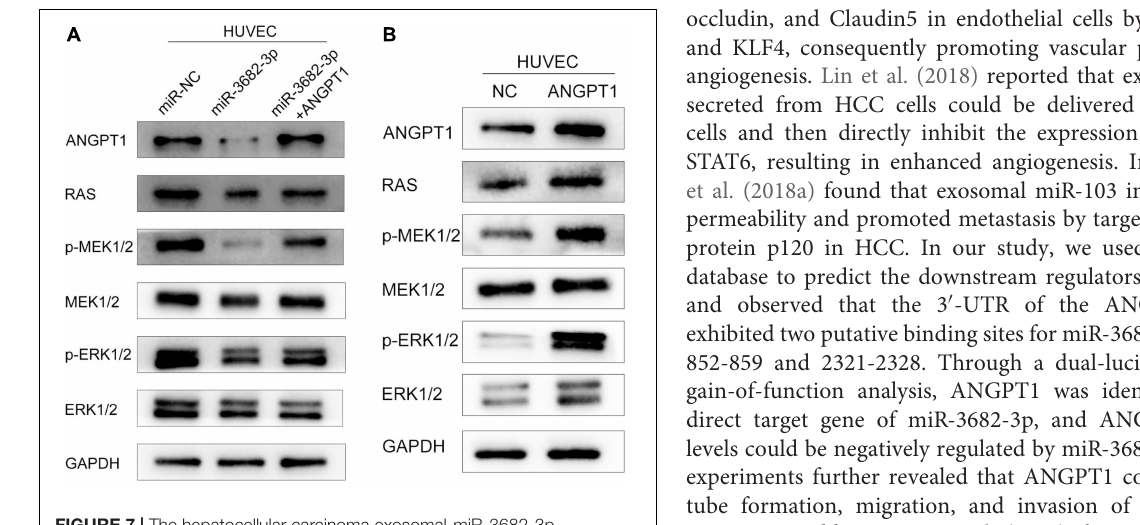
FIGURE 7 | The hepatocellular carcinoma exosomal-miR-3682-3p suppressed HUVECs via ANGPT1-RAS-MEK1/2-ERK1/2 signaling axis. (A) Exosomal-miR-3682-3p suppressd the expression of p-MEK1/2, p-ERK1/2, and ANGPT1 and this effet can be counteract by ANGPT1. (B) Western blot assays showed that overexpression of ANGPT1 also activated the RAS-MEK1/2-ERK1/2 pathway in